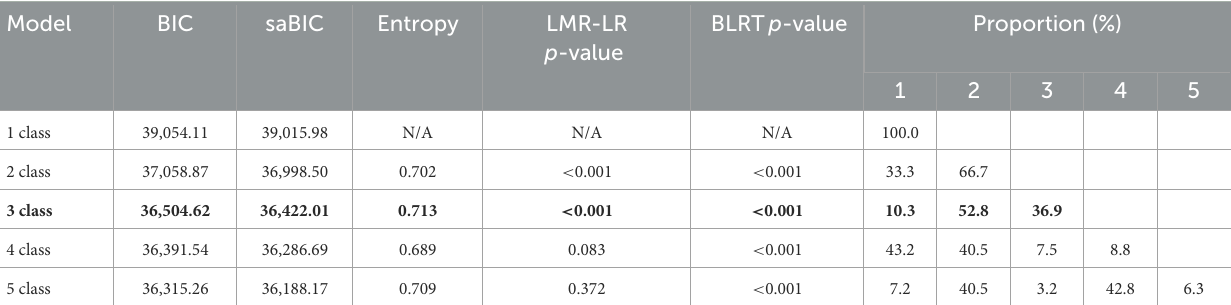
TABLE 2 Comparison between fit indices of latent profile analysis ( n =